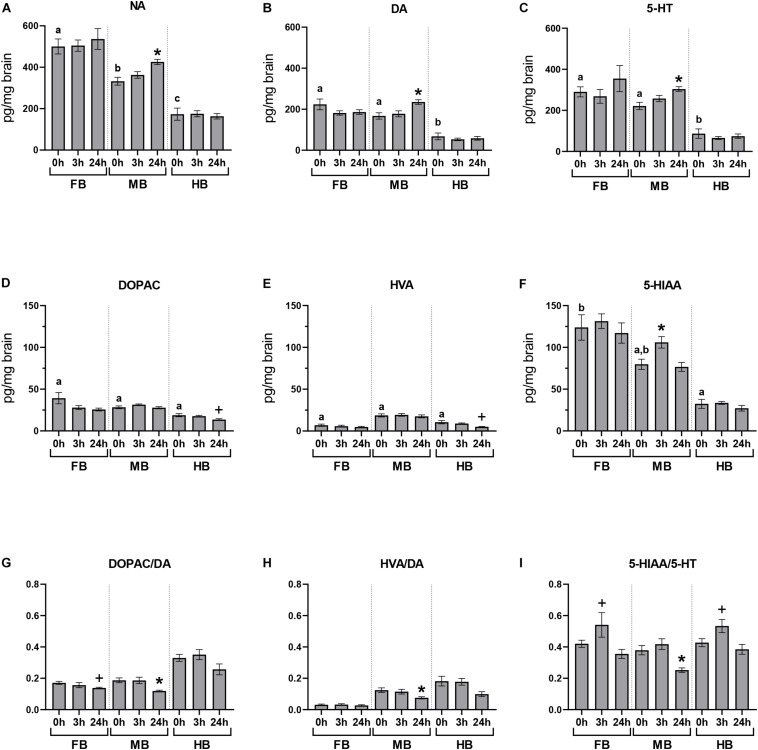
Acute handling effects on neurotransmitter concentrations in the brain of maraena whitefish. The effects of acute stress were analyzed section-wise at 0 h (n = 16), 3 h (n = 8), and 24 h (n = 8) after exposure to acute handling for (A) NA; (B) DA; (C) 5-HT; (D) DOPAC; (E) HVA; (F) 5-HIAA concentrations (pg/mg tissue); and the ratios of (G) DOPAC/DA; (H) HVA/DA; and (I) HIAA/5-HT. Comparisons between handling and control groups were tested for statistical significance using one-way ANOVA and Dunnett’s test for multiple comparisons and is indicated by (*) at p < 0.05 or non-significant tendency indicated as (+) at 0.05 < p < 0.10. The controls of the acute stress experiments (0 h; n = 16) were used to determine the abundance and distribution of neurotransmitters and metabolites in the three brain sections of undisturbed maraena whitefish. Statistical analysis was performed using ANOVA with the Tukey test (p < 0.05). Error bars indicate SEM; different characters (a–c) above the bars indicate statistically significant concentration differences between brain regions and within time points.